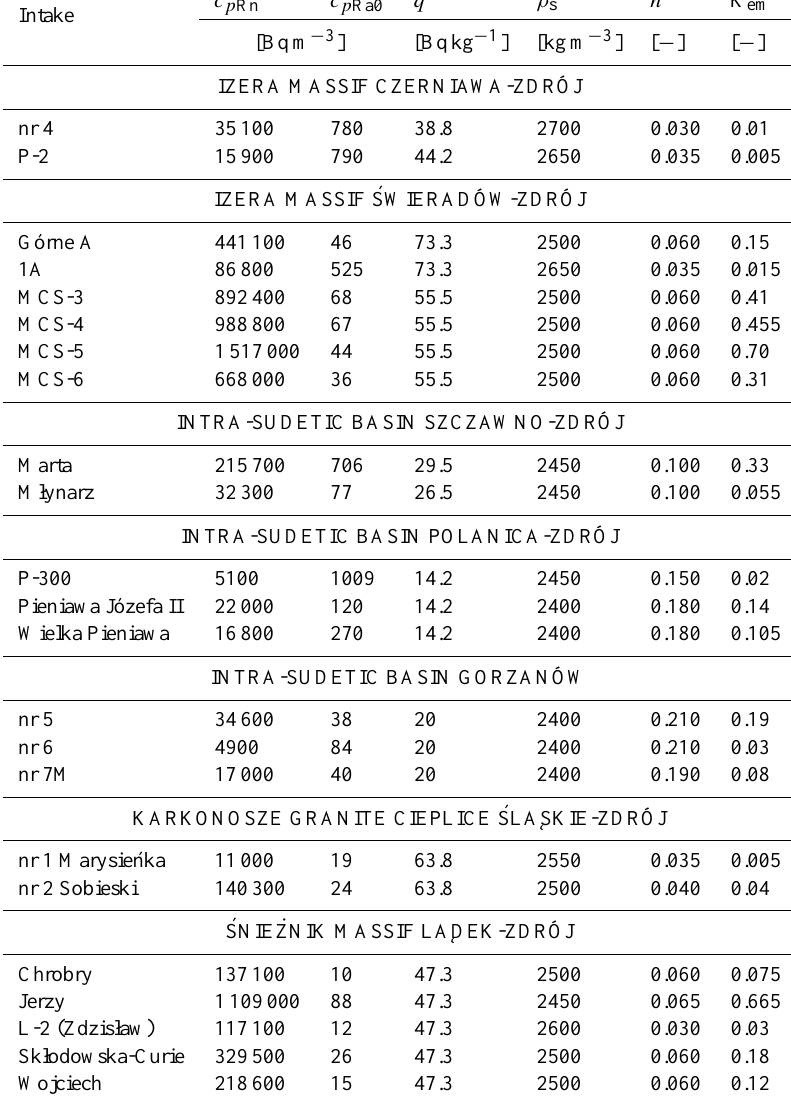
Table 2. Values of the parameters used for the K em calculation and obtained from Eq. (1) K em values for reservoir rocks supplying with groundwater selected intakes in the area of the Sudetes (according to Przylibski, 2005). Symbol explanations the same as for Eq.